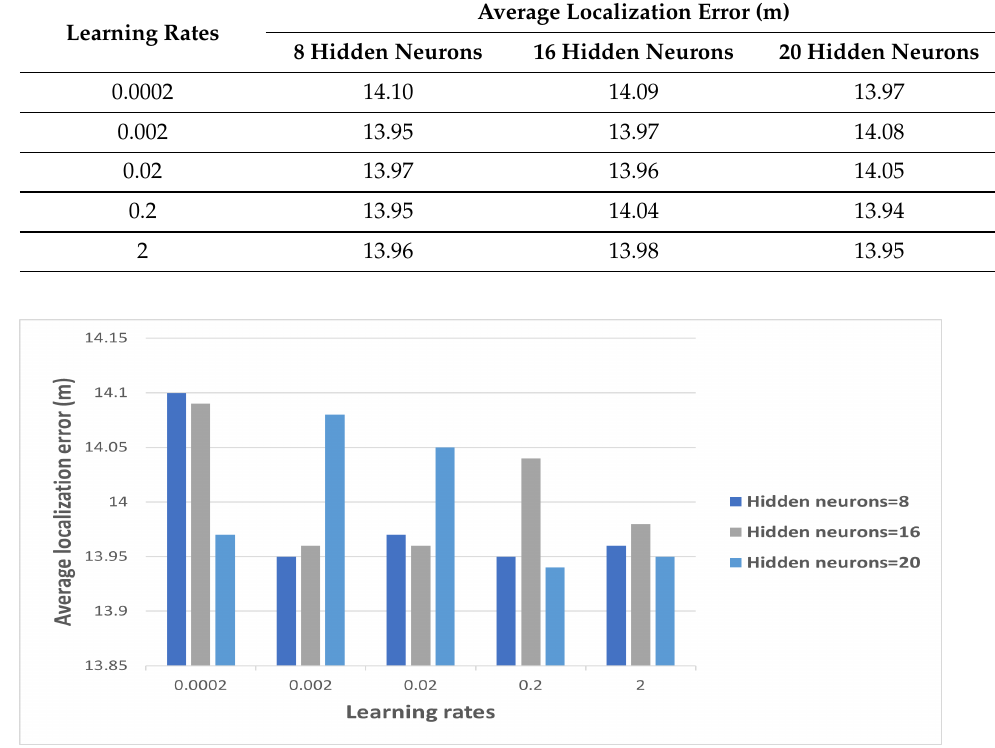
Table 2. Accuracy of the used RNN based localization architectures with the used learning rates in NLOS.